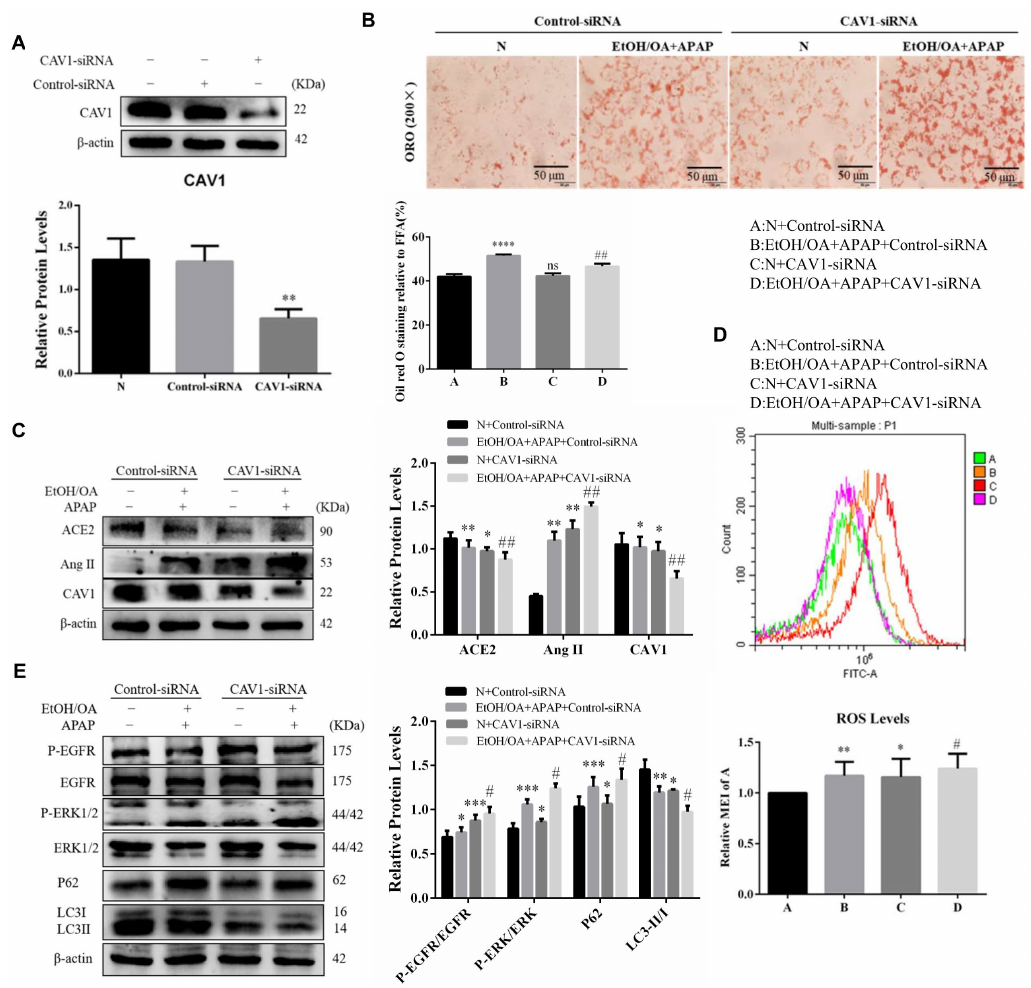
Figure 7. CAV1 silencing exacerbated lipid accumulation and activated the Ang II/EGFR/ERK signaling in L02 cells induced by EtOH/OA and APAP. ( A ) Western blot analysis of CAV1 protein levels. ( B ) Representative images of ORO staining of lipid droplets in L02 cells (Scale bar = 50 μm). ( C ) Western blot analysis of ACE2, Ang II and CAV1 protein levels. ( D ) ROS levels. ( E ) Western blot analysis of p-EGFR/EGFR, p- ERK/ERK, P62 and LC3 II / I protein levels. Data represent the mean ± SEM (n = 3 independent experiments). * p < 0.05 vs. N + Control-siRNA group; ** p < 0.01 vs. N + Control-siRNA group; *** p < 0.001 vs. N + Control-siRNA group; **** p < 0.0001 vs. N + Control-siRNA group; ns p > 0.05 vs. N + Control-siRNA group; # p < 0.05 and ## p < 0.01 vs. EtOH/OA + APAP + Control-siRNA